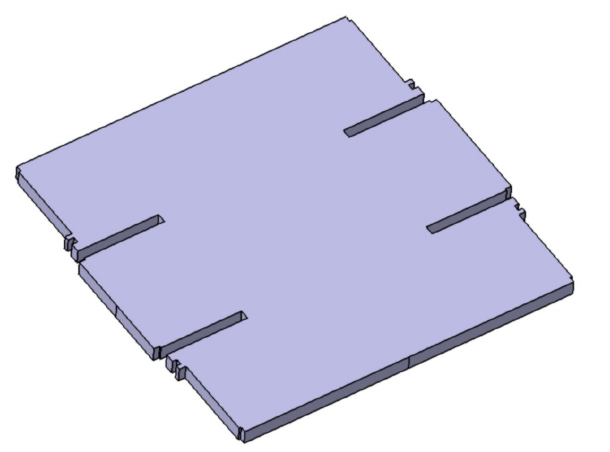
Figure 19. A schematic view of the IM of the SE of the MEMS